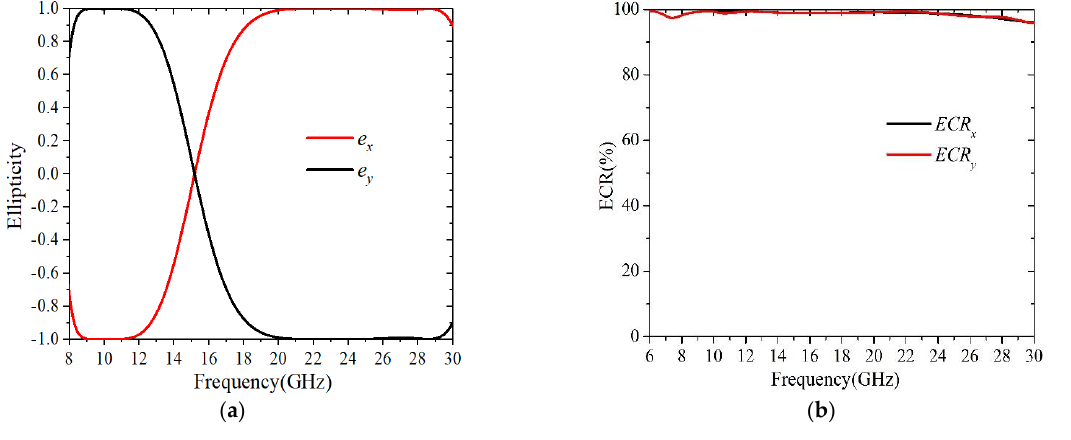
Figure 4. ( a ) Normalized ellipticity; ( b ) Energy conversion ratio.